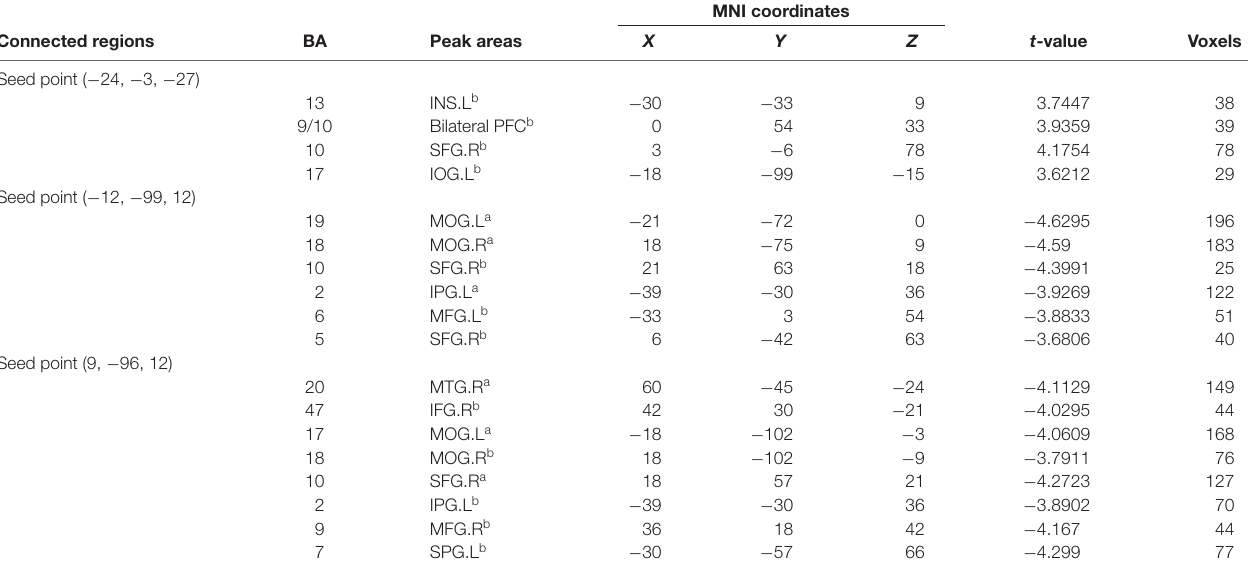
MNI coordinates